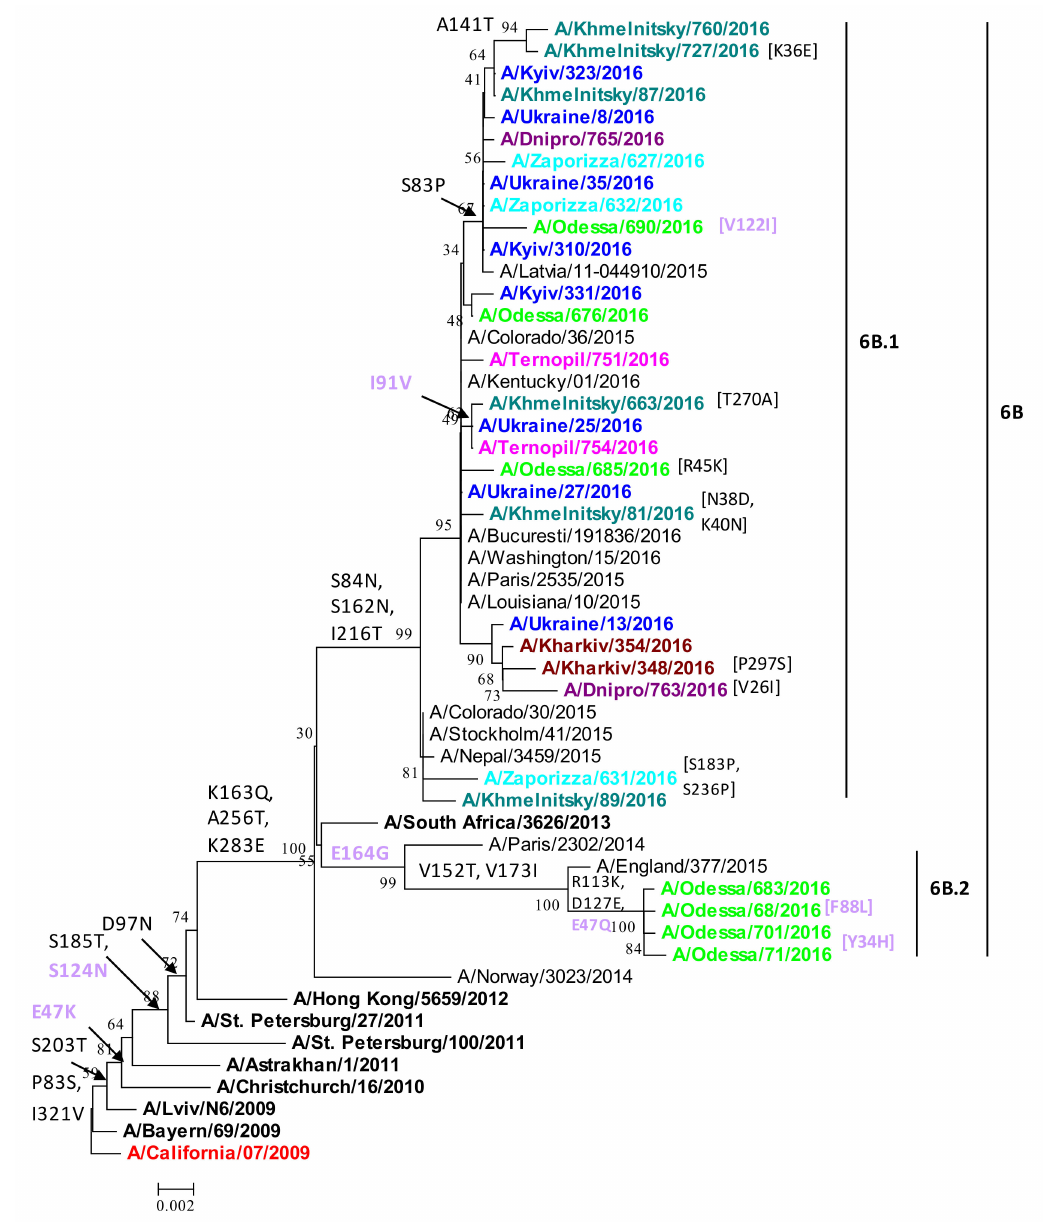
Figure 2. Phylogenetic analysis of A(H1N1)pdm09 influenza virus hemagglutinin (HA) nucleotide sequences from the 2015/16 season in Ukraine. Phylogenetic trees were constructed by the NJ (neighbor-joining) method, and Kimura 2-parameter model, with 1000 bootstrap replications. Amino acid variations are labeled for 6B.1 and 6B.2